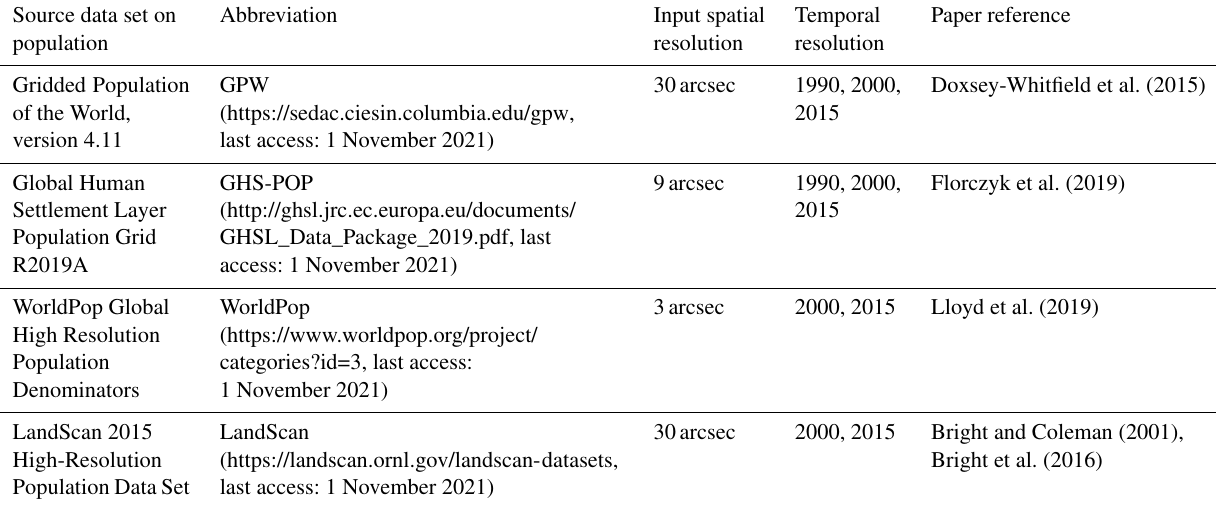
Table 2. Population data sets used to estimate persons living in the low-elevation coastal zones (LECZs). Source data set on